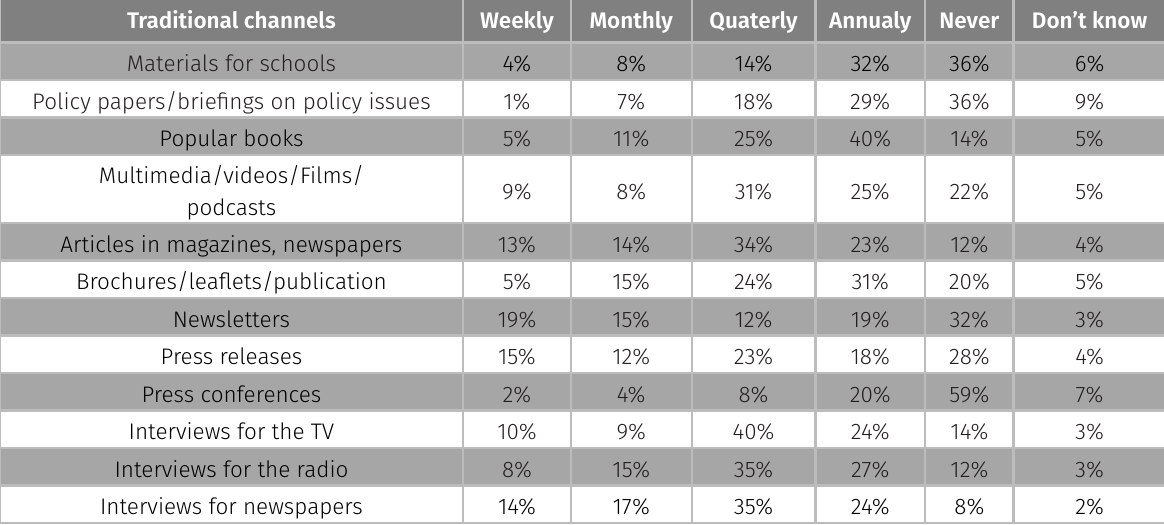
Table IV. Frequency of communication through different channels.